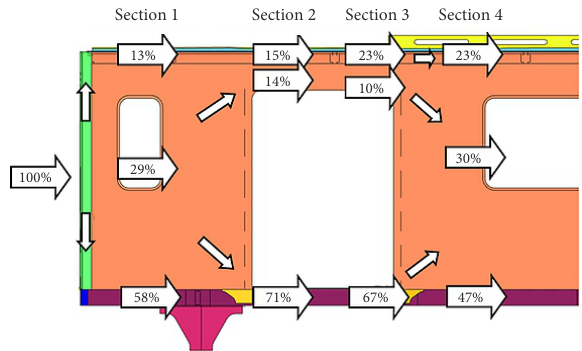
Figure 8. Transfer path distribution of the collision